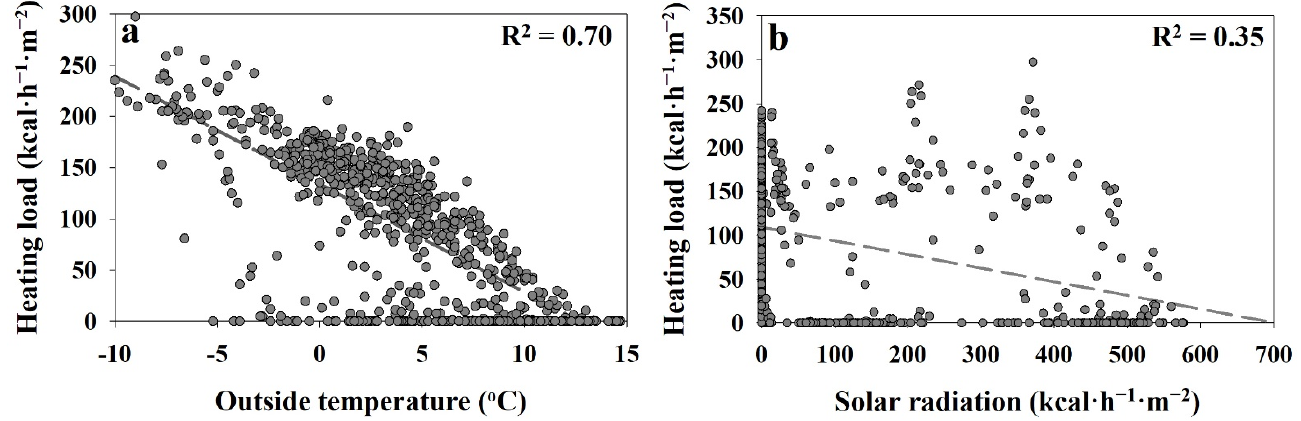
Figure 11. Analysis of greenhouse internal environment during summer: ( a ) GH 1 and ( b ) GH 2.